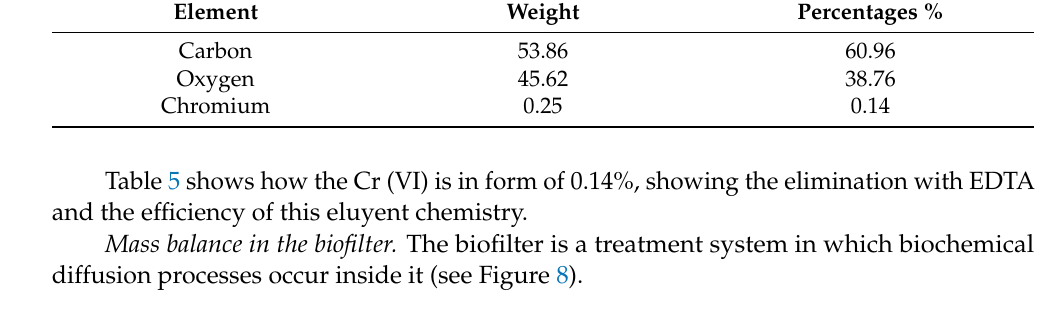
Table 5. Physicochemical characterization of the ECFe sample after treatment. Element